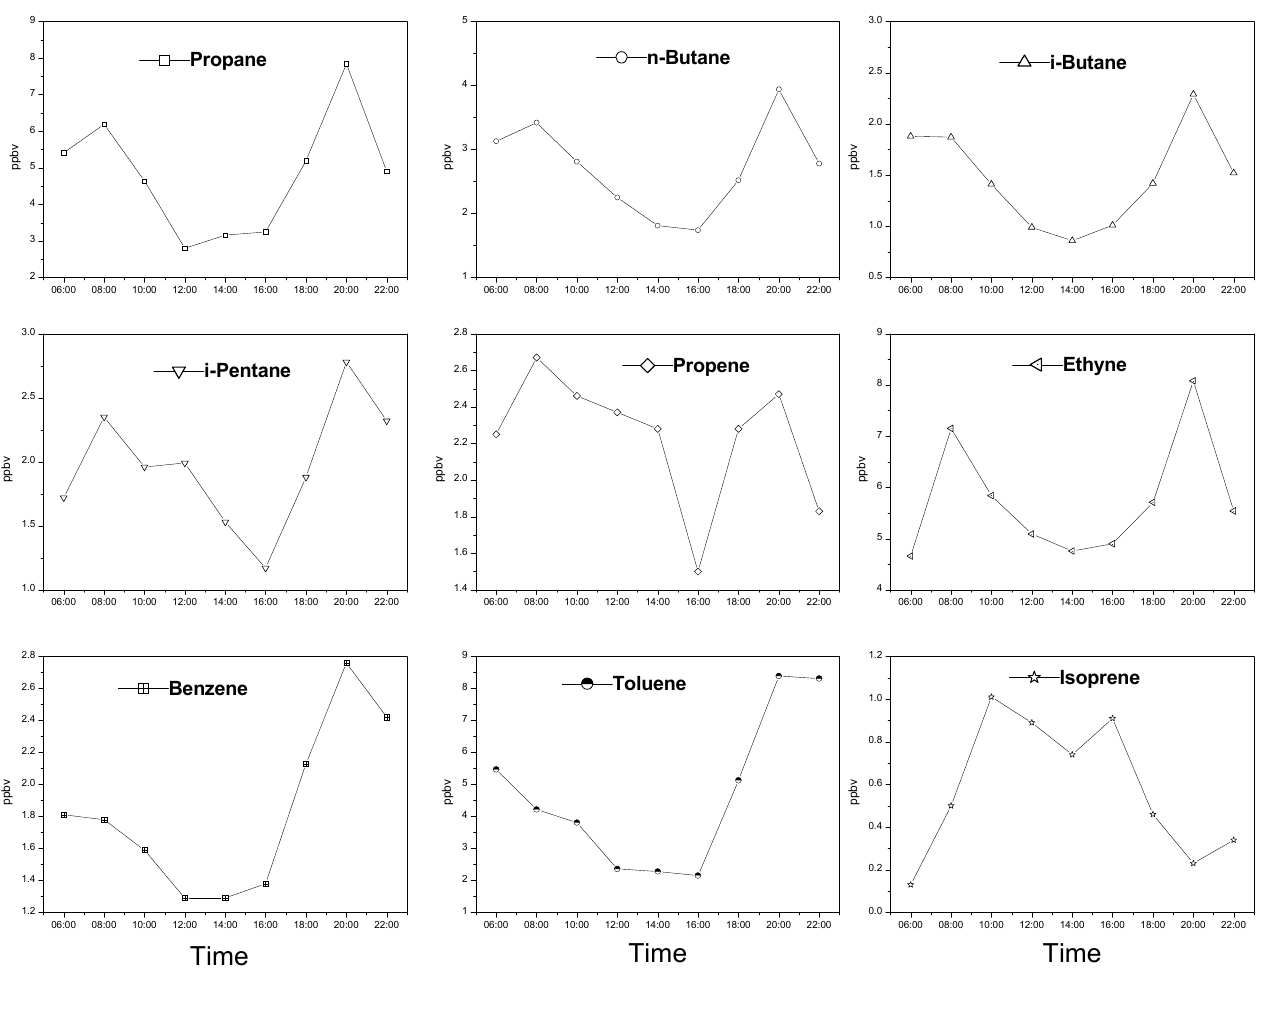
Figure 5. Diurnal variations of selected NMHCs in